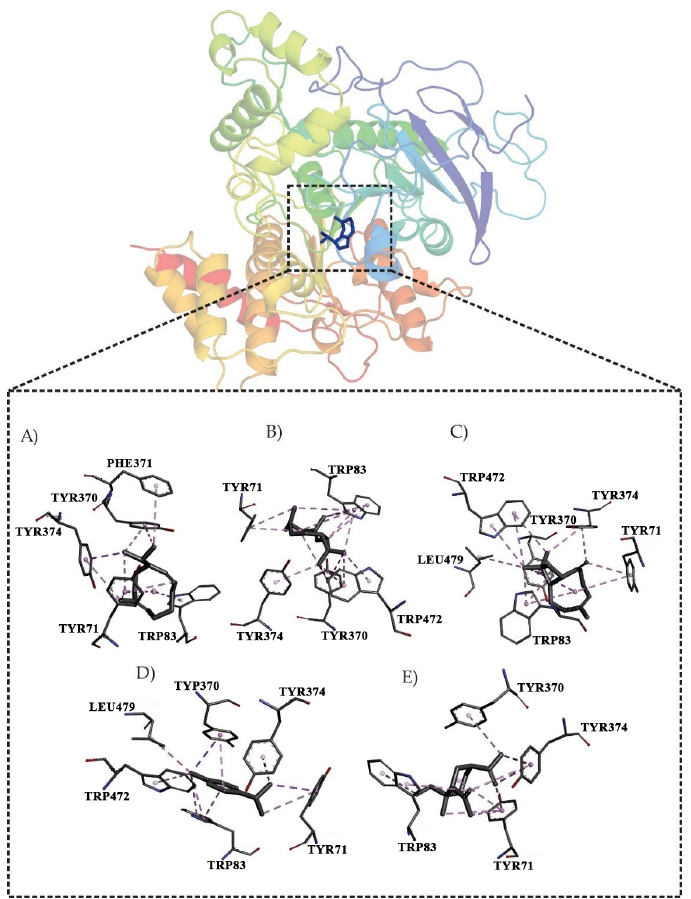
Figure 1. Molecular interactions in the binding pocket of AChE. Germacrene ( A ); bicyclogermacrene ( B ); ( E )-caryophyllene ( C ); γ -terpinene ( D ); δ -elemene ( E